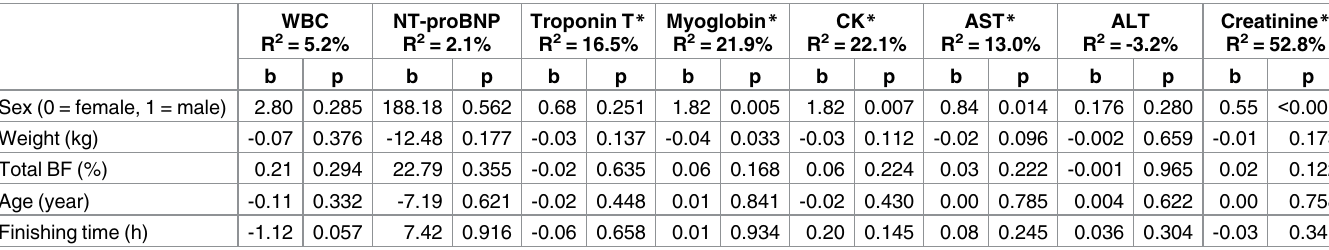
Table 2. The outcome of the linear regression